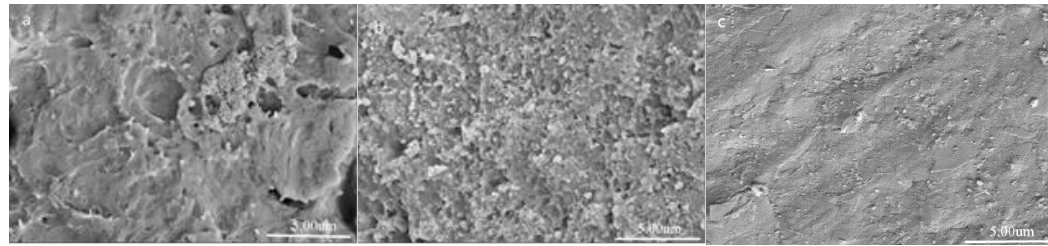
Figure 5. FESEM images of the fracture surfaces of ABS 1 , ABS 2 , and ABS 4 .